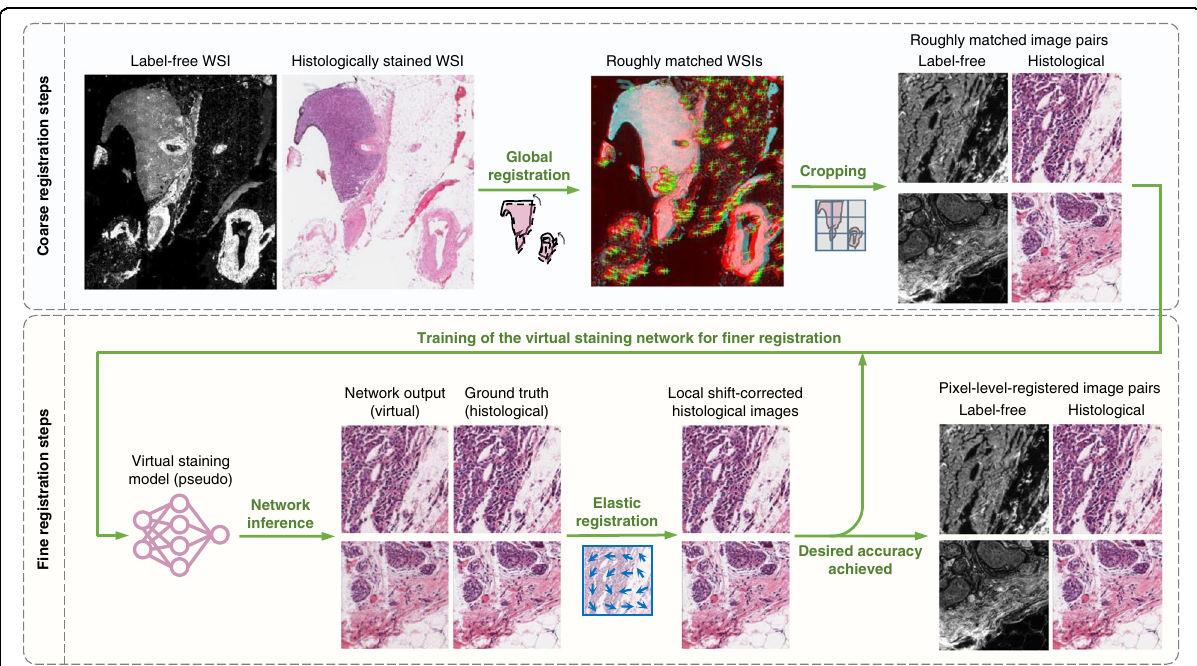
Fig. 6 Multi-stage image cross-registration work fl ow. The label-free WSI and its corresponding histologically stained WSI are fi rst roughly registered and cropped into coarsely matched image pairs. Then a pseudo virtual staining model is trained to transform the label-free images into the histological images, which assists the local feature registration using an elastic pyramidal registration